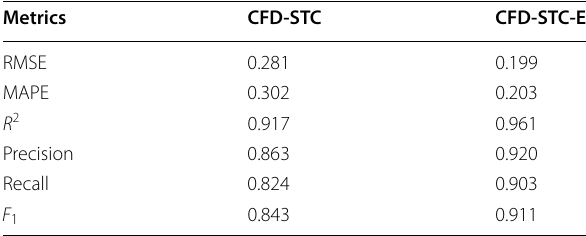
Table 7 The effectiveness of the verification method in